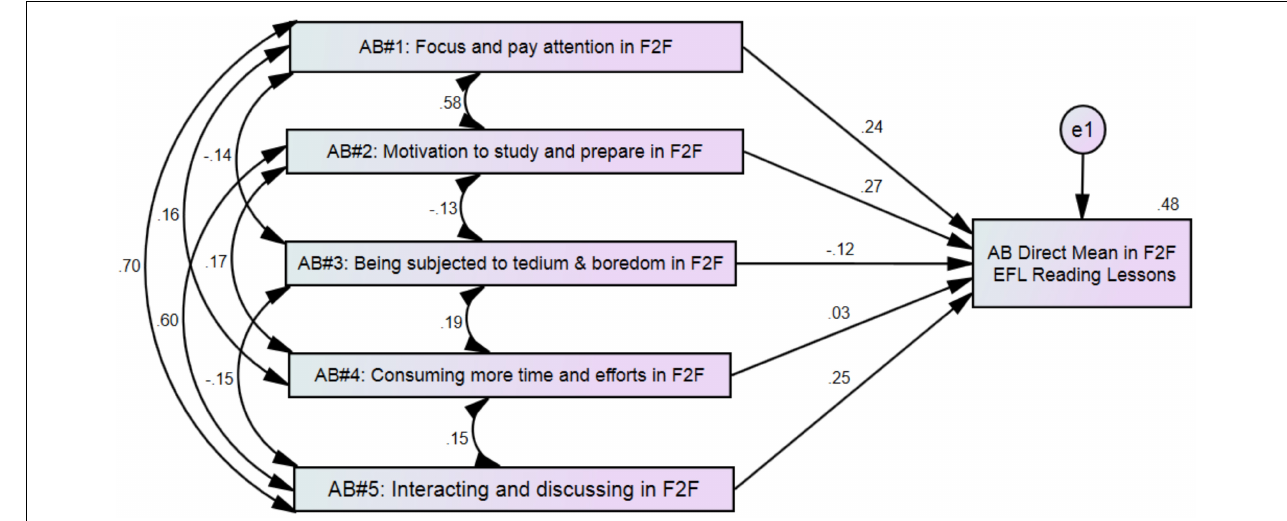
FIGURE 2 | Attitude toward behavior (AB) diagram for the FLL group.